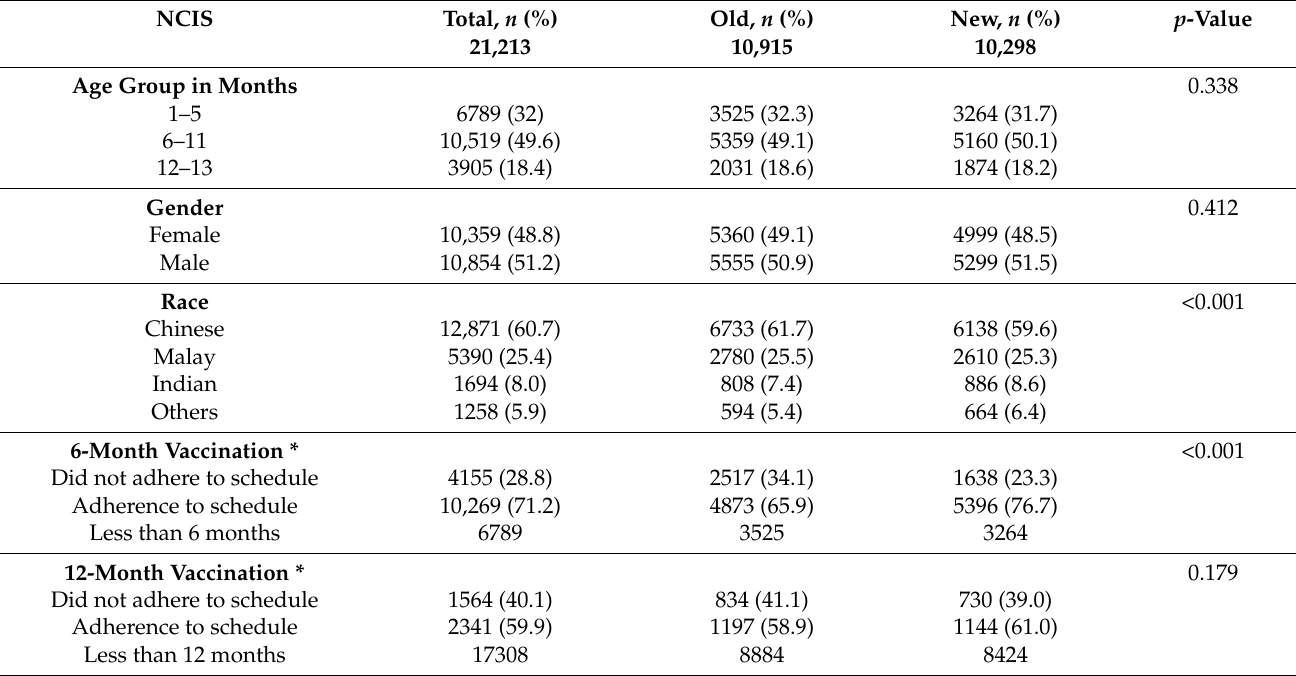
Table 2. Demographics of children in both